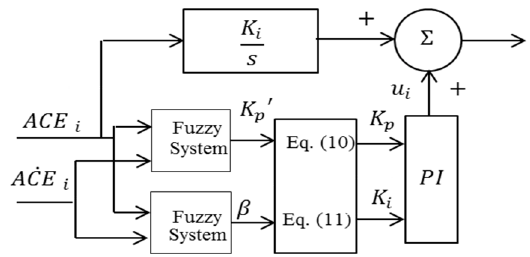
Figure 2. Regulation of the speed droop governors.